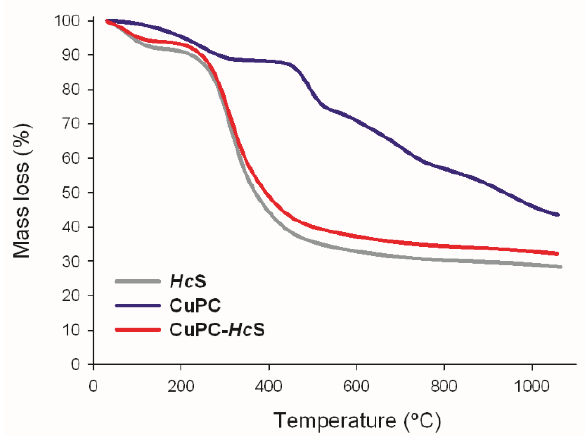
Figure 5: TG curves of thermal decomposition of the H. communis skeleton, copper phthalocyanine and selected sample obtained after the adsorption process (pH=2, 120 min, 400